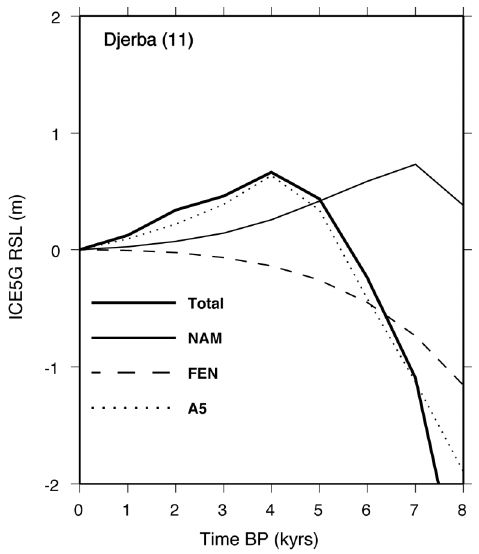
Fig. 8. Contributions to RSL due to individual com- ponents of ICE5G (VM1) at the site of Djerba (see fig. 3a).